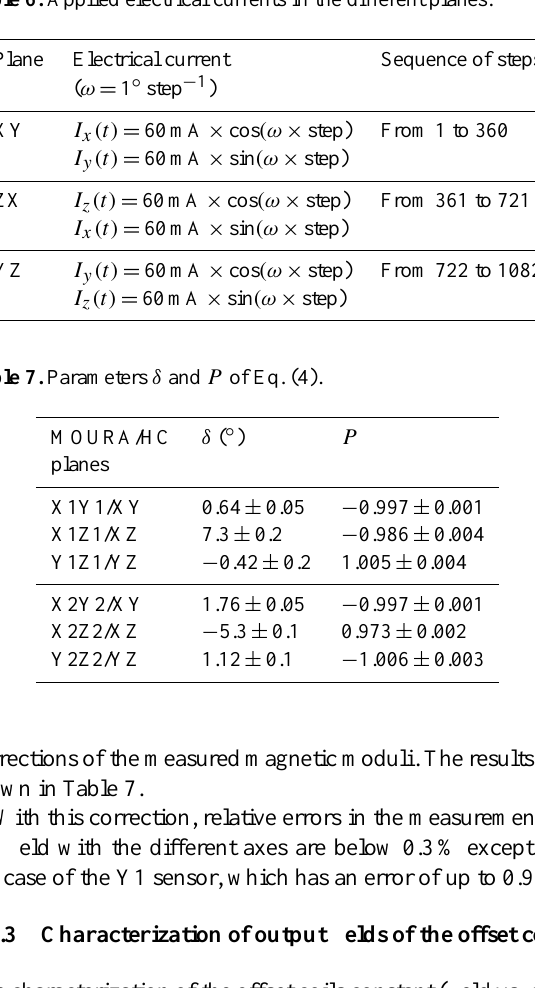
Table 6. Applied electrical currents in the different planes.